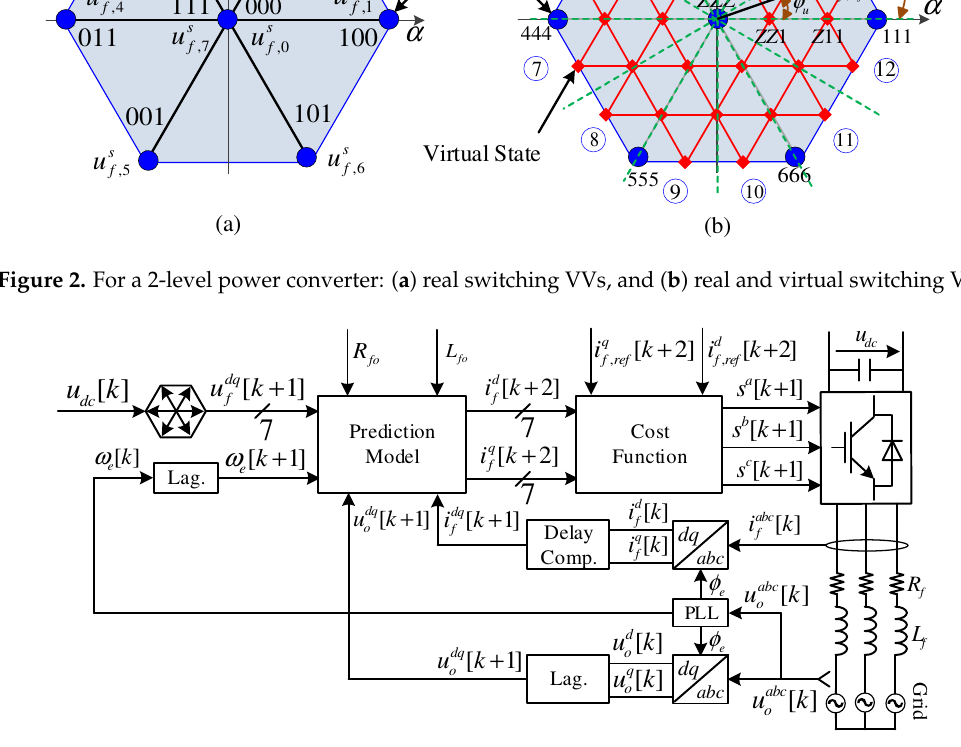
Figure 3. Block-diagram of the traditional DMPC for power converters tied to the